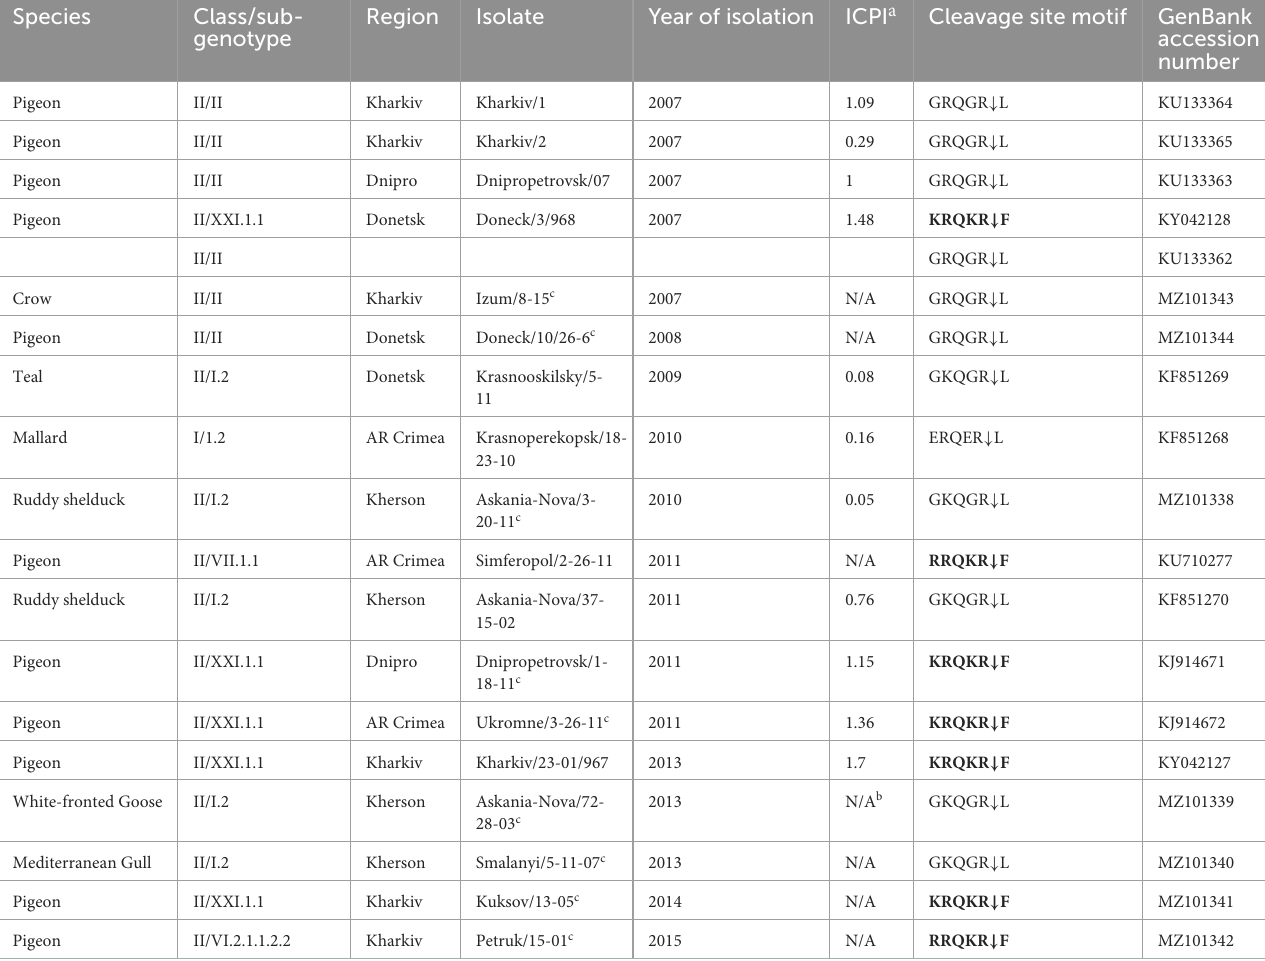
TABLE 1 Background information data for NDV isolates recovered in Ukraine between 2006 and 2015.